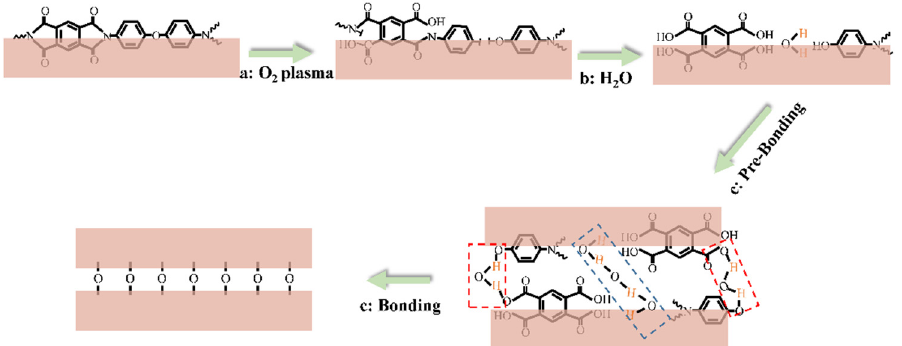
Figure 7. Schematic of polyimide surface activation and wetting bonding